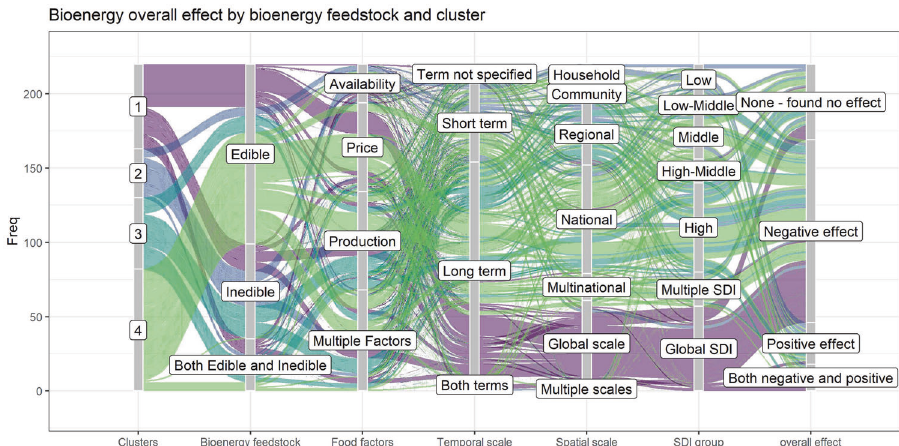
Fig. 8 Cluster characteristics and cluster descriptions. Alluvial plot fl owing left to right of clusters one through four identi fi ed followed by the type of bioenergy, the food factors and the overall effect of the bioenergy on food security from a review of 220 journal articles. *Bioenergy type “ not speci fi ed ” was not included in the cluster